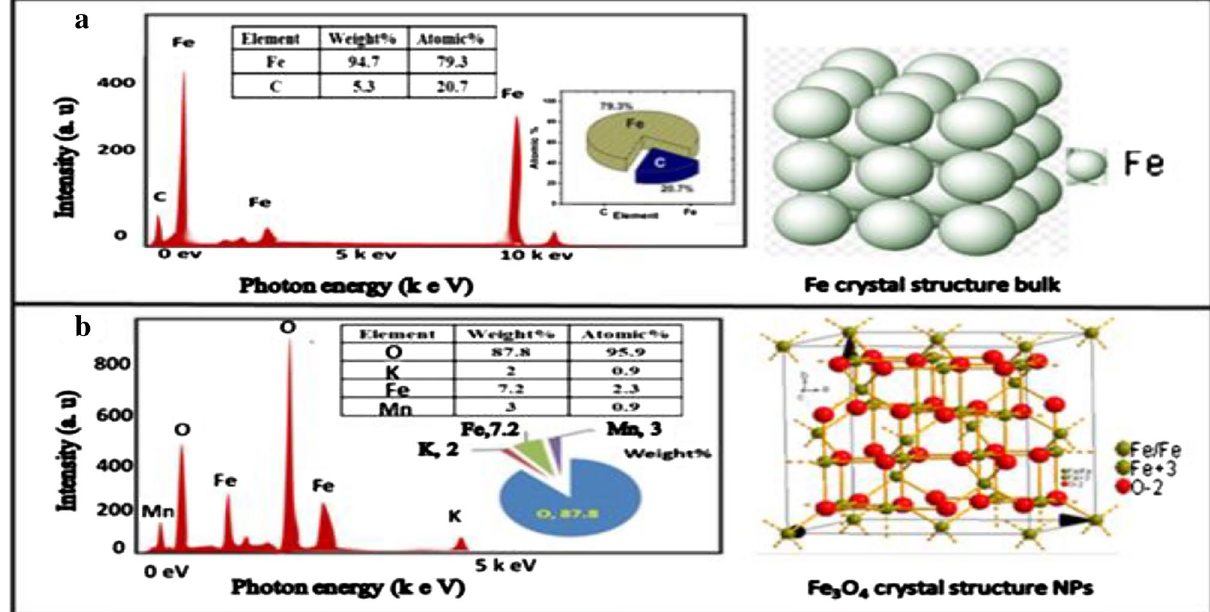
Figure 7. EDX of Fe-plate active material with crystal structure in ( a ), and EDX of SPION NPs in solution KMnO 4 with a crystal spinel Fe 3 O 4 NPs structure in ( b